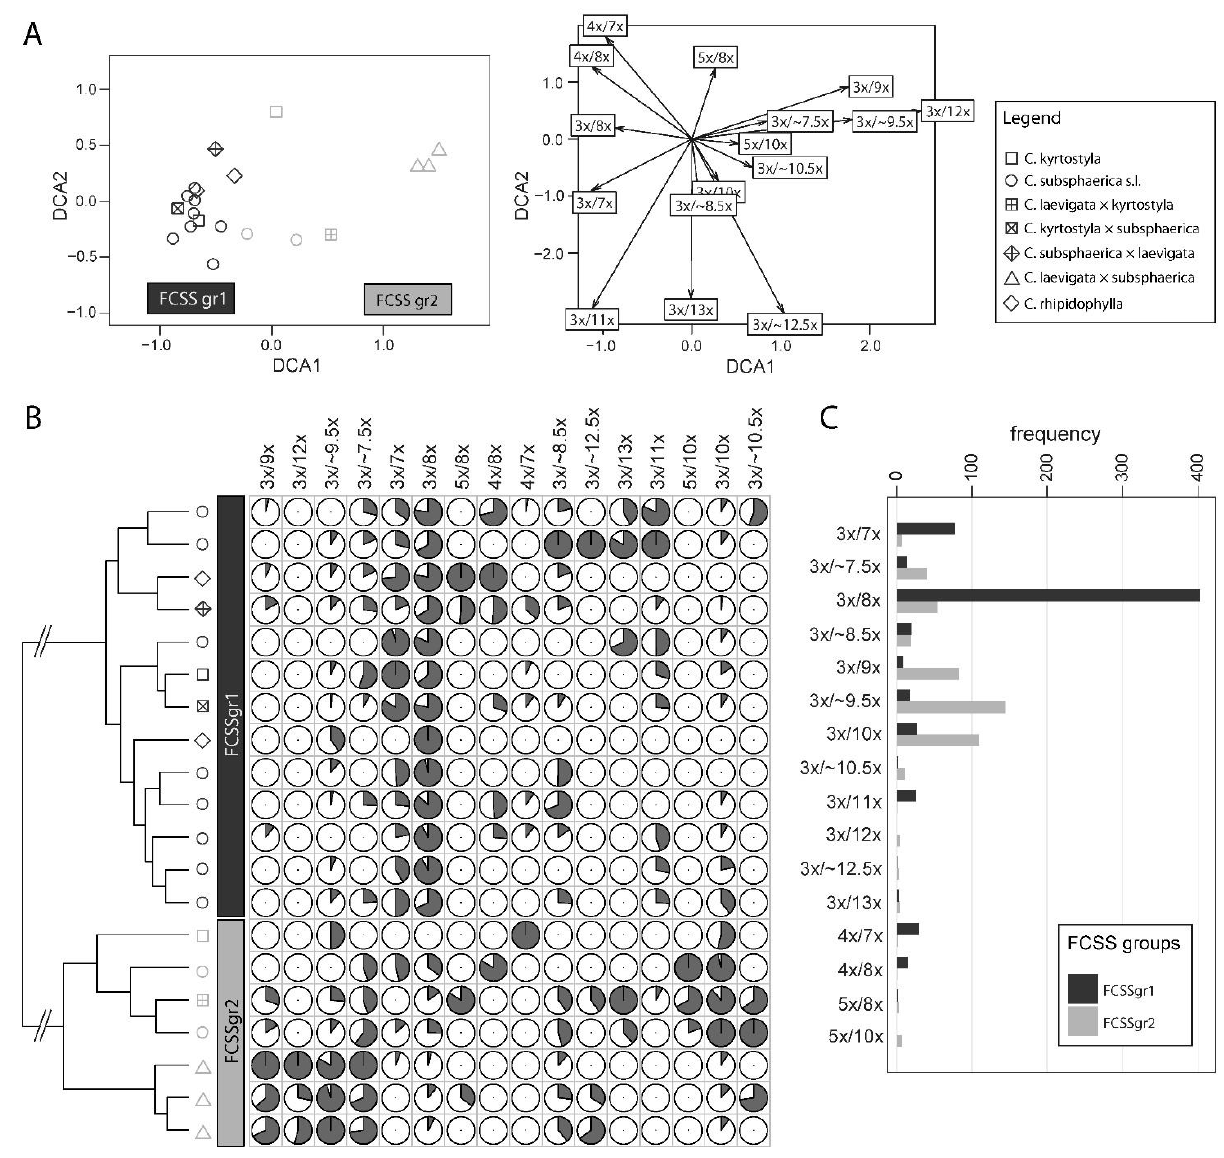
Figure 7. Interindividual quantitative variation in the embryo and endosperm formation of the triploids of Crataegus allows the recognition of two groups of plants, FCSSgr1 and FCSSgr2. ( A ) Detrended correspondence analysis (DCA) of 20 individual plants based on the embryo and endosperm ploidy level data of their seeds. The scores for the individuals are shown on the left panel and those for the seed categories on the right. The seed categories are expressed as ploidy level of embryo before slash and ploidy level of endosperm after slash. ( B ) Hierarchical clustering (HC) of 20 individuals based on the embryo and endosperm ploidy level data of their seeds. The data were percent maximum transformed on the columns prior to HC and then displayed as heatmap. The seed categories are expressed as in A. ( C ) Barplot of the frequency data of the most frequent seed categories (≥4 cases) in FCSSgr1 and FCSSgr2. Seed categories are expressed as in A .